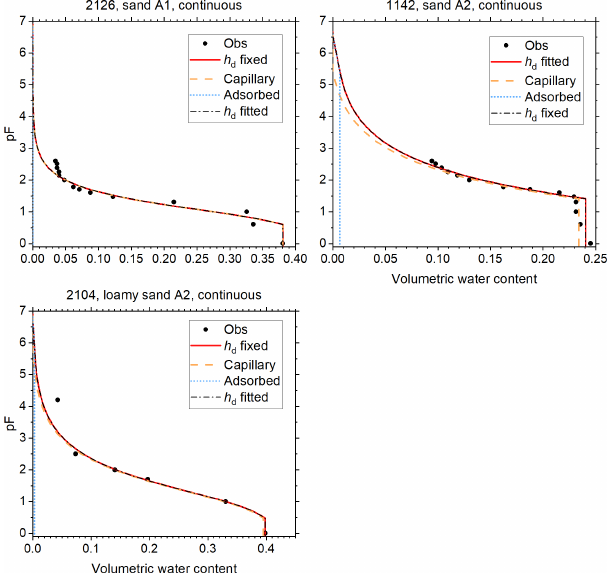
Figure 5. Soil water retention data and fitted curves for soils of classes A1 and A2 of Twarakavi et al. (2010). Curves fitted with h d fixed at − 10 6 . 8 cm H 2 O, and with h d fitted with a cap at that value are shown. The one with the lowest root mean square error is shown as a red solid line. The volume fractions of capillary-bound water and water adsorbed in films is shown for this curve. The other curve is shown as black dash–dot line. This curve has not been corrected for continuity at the junction point. The vertical axis denotes the logarithm (base 10) of the absolute value of the matric potential in cm H 2 O.